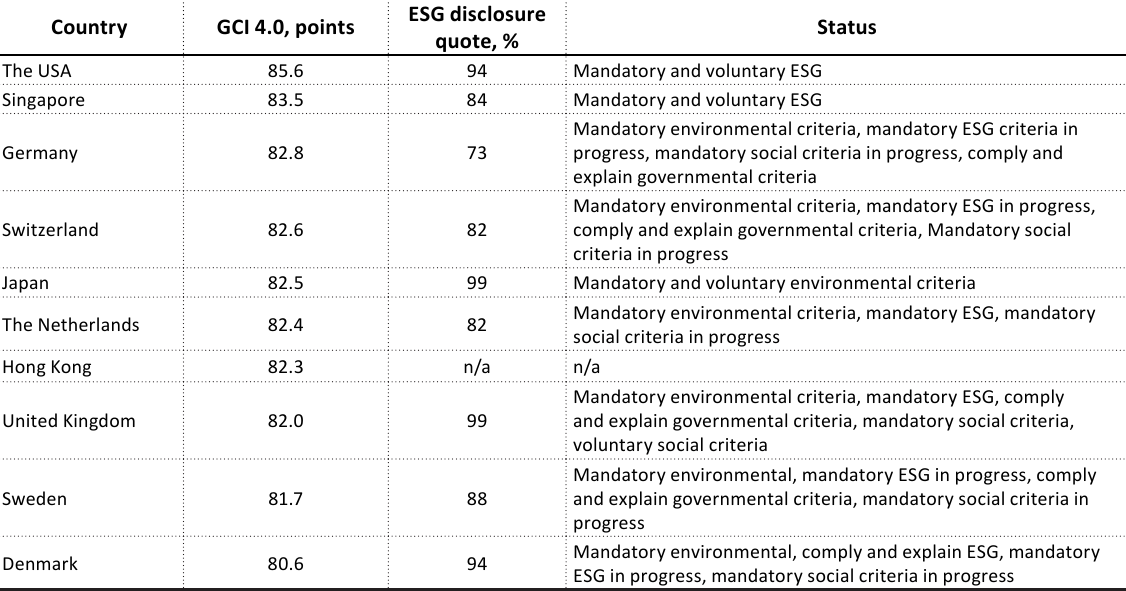
Table 1. Countries with the highest share of ESG disclosure in annual company reports and regulatory requirements for its